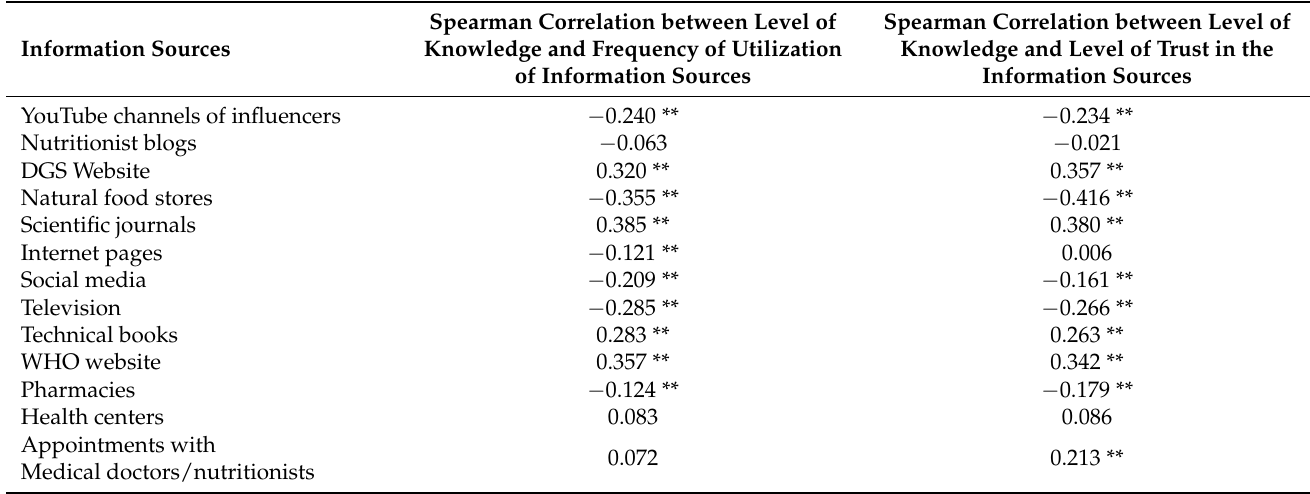
Table 6. Associations between level of knowledge and the frequency of utilization and level of trust in the information sources. Spearman Correlation between Level of Spearman Correlation between Level of Information Sources Knowledge and Frequency of Utilization Knowledge and Level of Trust in the of Information Sources Information